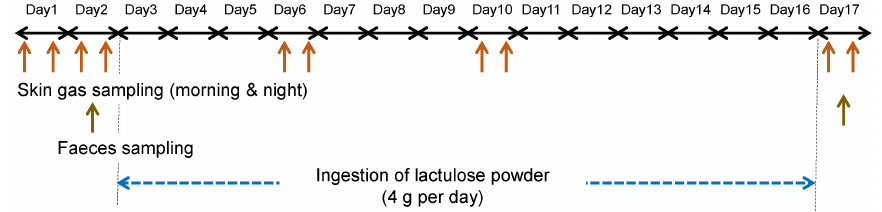
Figure 1. Schedule of skin gas and faeces samplings and ingestion of the tested disccharide